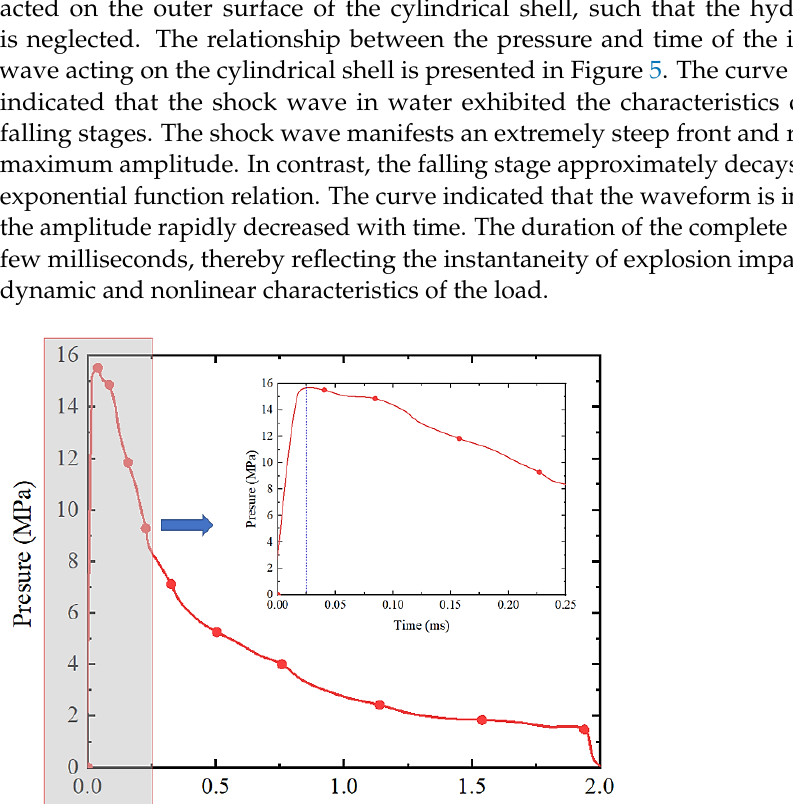
( b ) Axial strain at location C1 Figure 6. Comparison diagram of experimental and simulation.